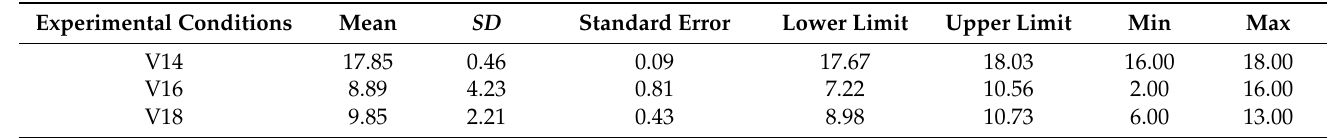
Table 9. Obstacles avoided in the car